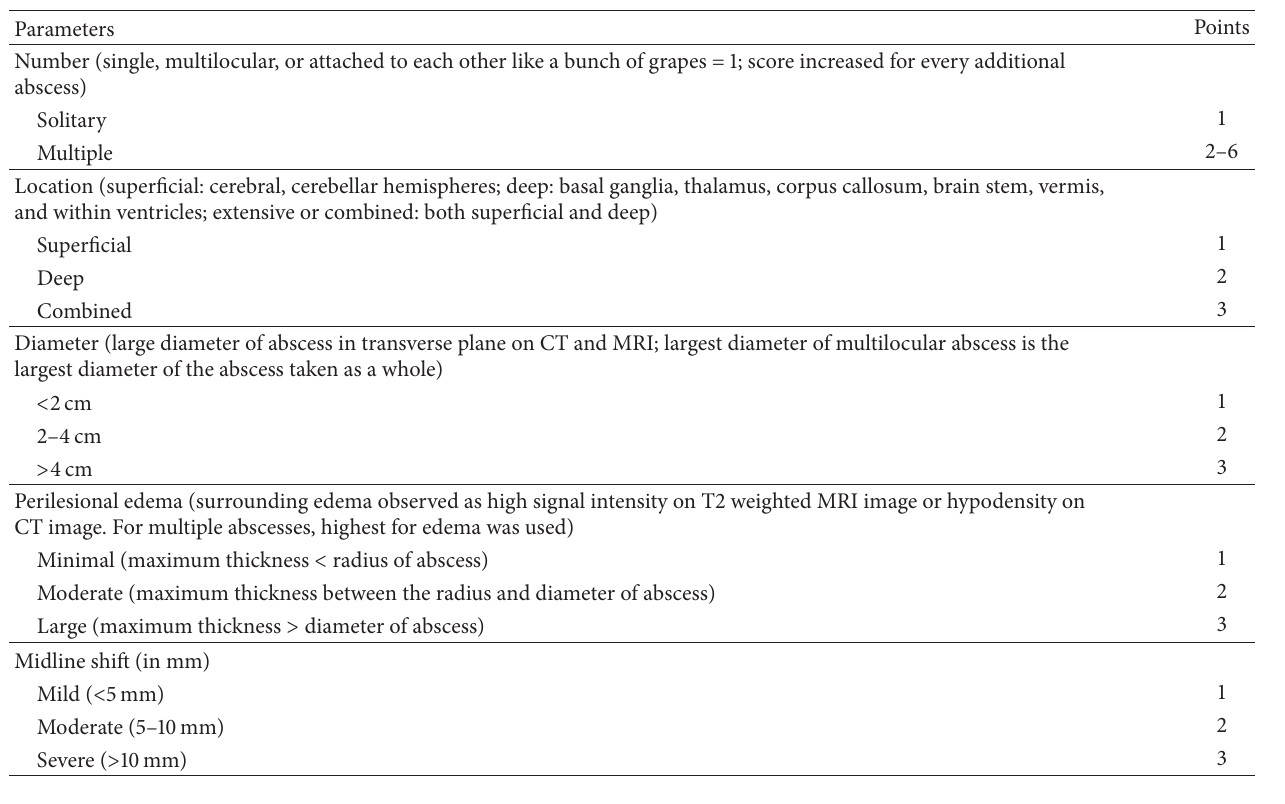
Table 3: Image severity index score